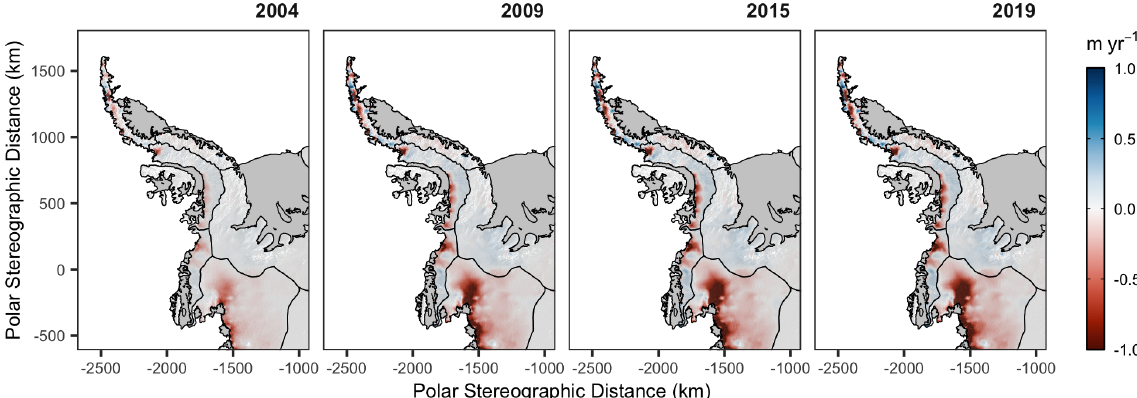
Figure 5. Temporal evolution of height changes due to ice dynamics for 4 years over the course of the 17-year study period. The colour scale is saturated at end points for plot clarity. The basin outlines and grounding line are overlain in black (Rignot et al., 2011b, 2013). Dark grey regions represent ice shelves (Depoorter et al., 2013). Data are overlain on the hill shade of the REMA DEM (Howat et al.,